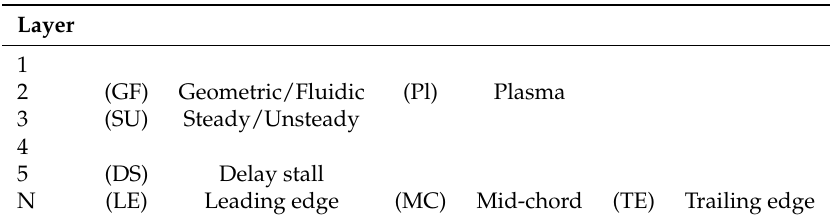
Table 2. Additional categories in actuator classification used by Johnson et al.